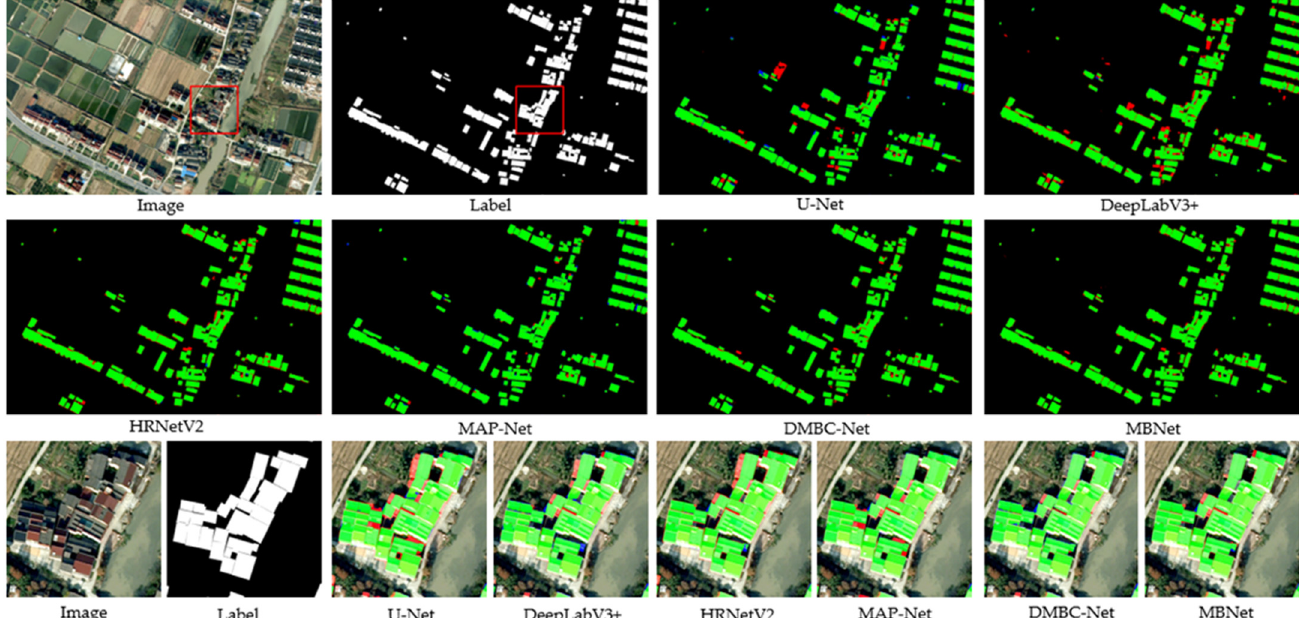
Figure 10. Segmentation results of the different SOTA methods on the plain landform scene 2 test dataset. The bottom row is a close-up view of the red box.